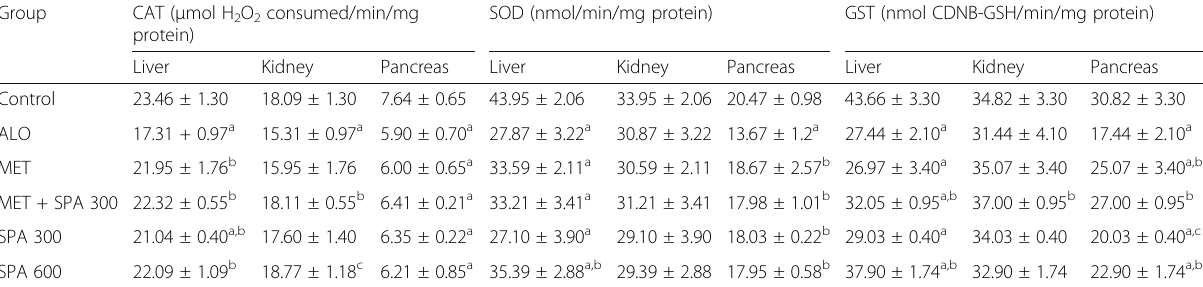
Table 5 Effect of methanol extract of S. sparganophora leaves on antioxidant enzymes in alloxan-induced hyperglycemic rats